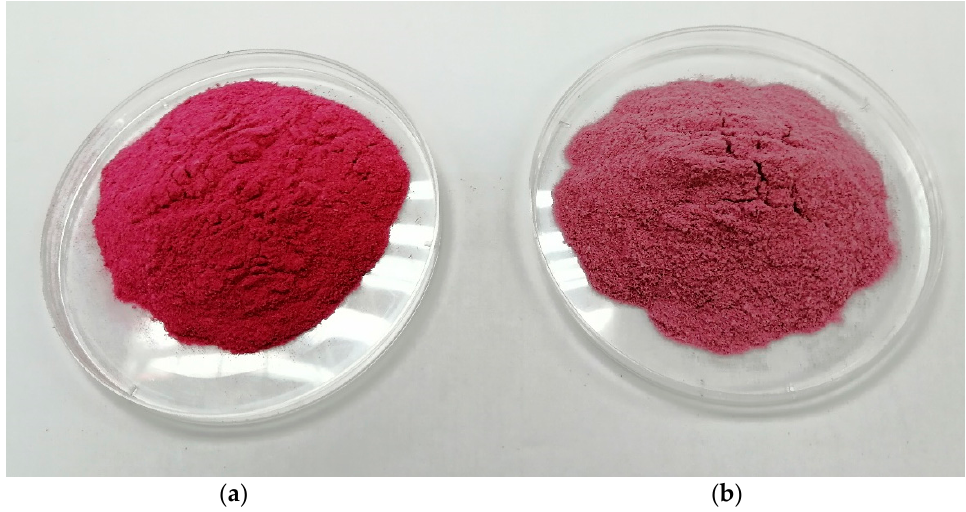
Figure 4. Drum-dried PSSP ( a ) with 0.6% CA and ( b ) without